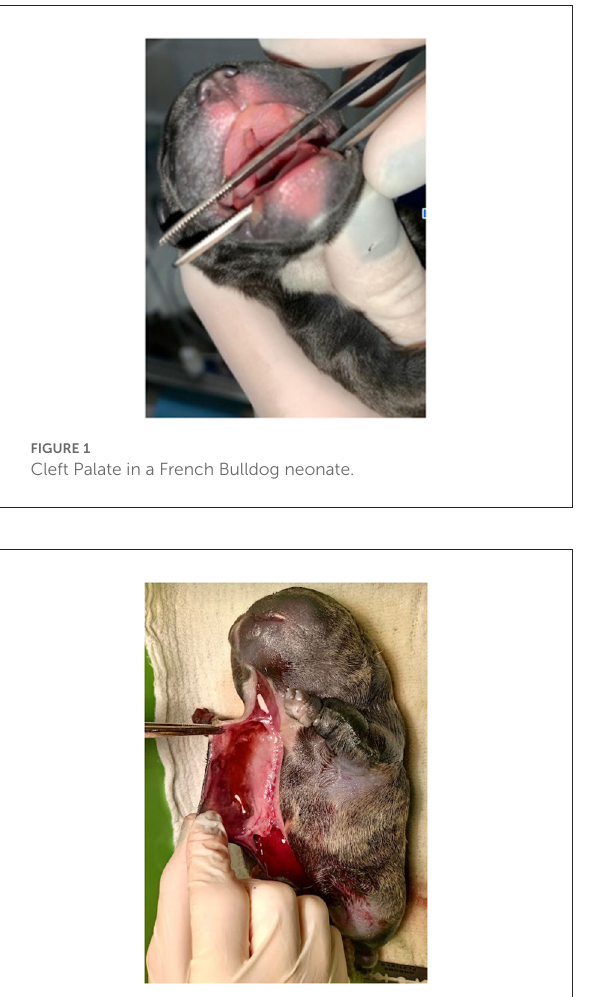
FIGURE2 Anasarca in an English Bulldog neonate. Note the accumulation of fluid in the subcutaneous tissue, a remarkable characteristic of this type of